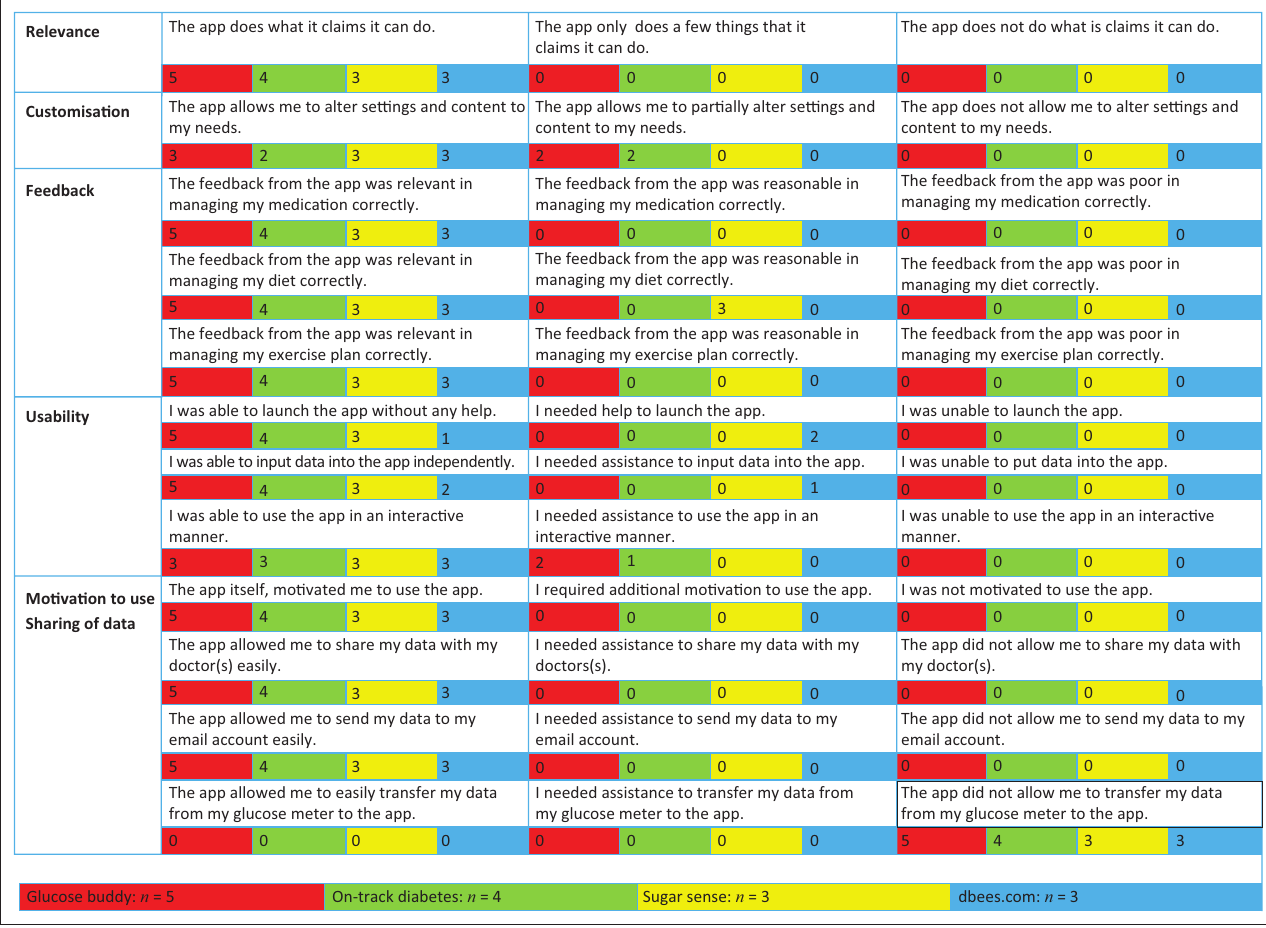
FIGURE 2: Evaluation criteria